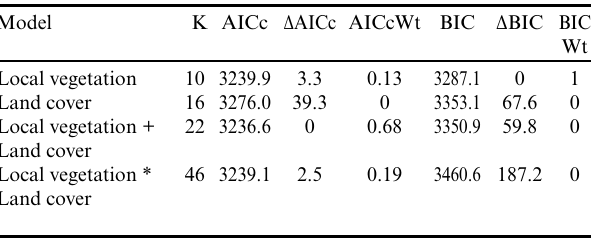
Table 2 . Comparisons of model fit based on Akaike’s Information Criteria adjusted for small sample size (AICc) and Bayesian Information Criteria (BIC) for each of the four models